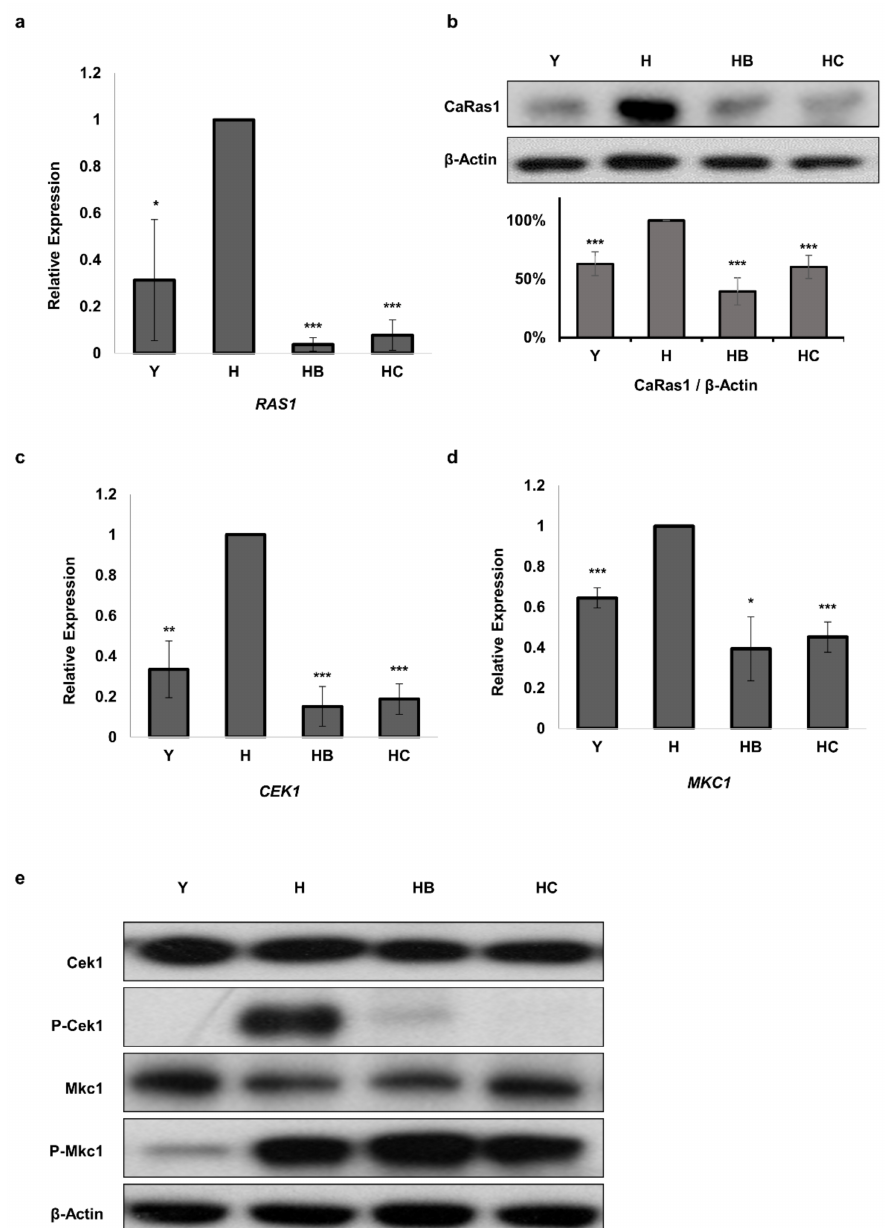
Figure 5. mRNA and protein expression levels of RAS1 and mRNA expression levels of MAPK were reduced by Molecule B and Molecule C treatments. However, the level of P-Mkc1 did not decrease, while that of P-Cek1 did, with these treatments. The BWP17 C. albicans strain was used for western blotting and real-time PCR analyses. ( a ) Relative mRNA expression levels of RAS1 were determined using real-time PCR. ( b ) In western blotting, CaRas1 was detected using the anti-Ras10 antibody, and β -actin was used as a loading control. The quantification graph by Image J software was prepared by normalizing the ratio of each CaRas1 blot to each β -actin loading control. The relative mRNA expression levels of CEK1 ( c ), and MKC1 ( d ) were determined using real-time PCR. ( e ) Western blotting was performed by detecting Phospho-Mkc1 and Phospho-Cek1 using an anti- phospho-p44/42 antibody. Mkc1 and Cek1 were detected using the anti-p44/42 antibody, and β -actin was used as a loading control. Y, yeast cells; H, hyphae induced cells; HB, hyphae induced cells treated with 8 µ g/mL Molecule B; HC, hyphae induced cells treated with 16 µ g/mL Molecule C. Each experiment was conducted in triplicate. The data represent the mean and standard deviation of three independent experiments. * p < 0.05, ** p < 0.01, *** p < 0.001 ( t